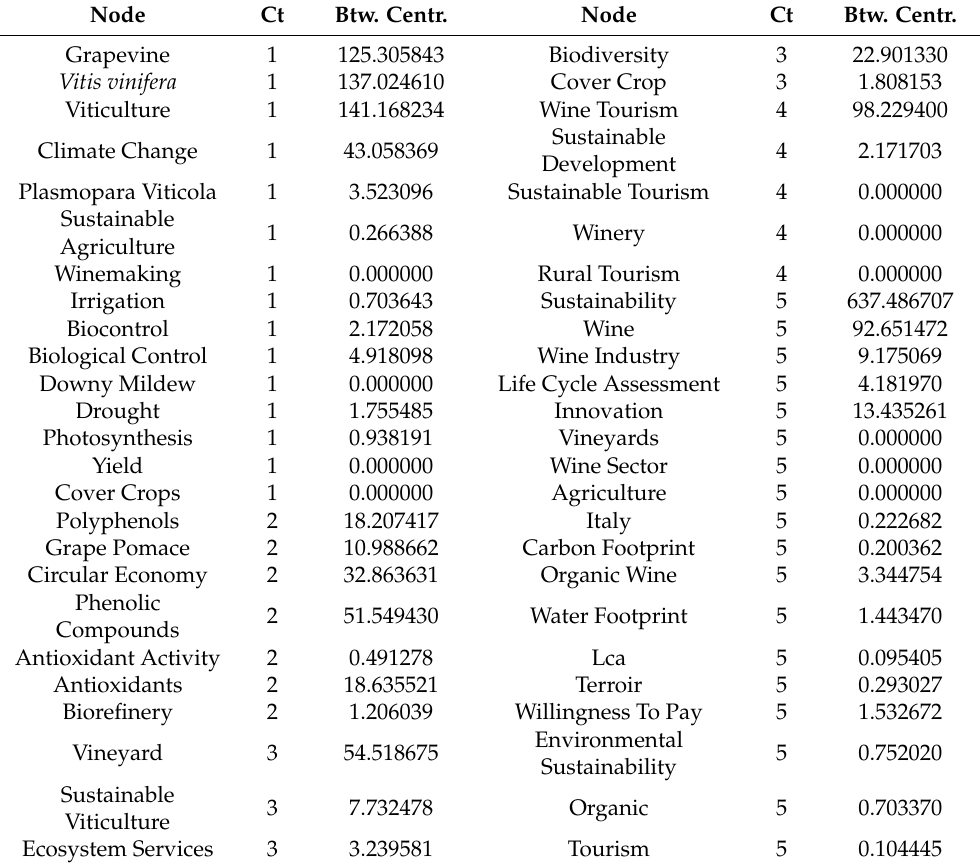
Table 10. Co-occurrence network: betweenness